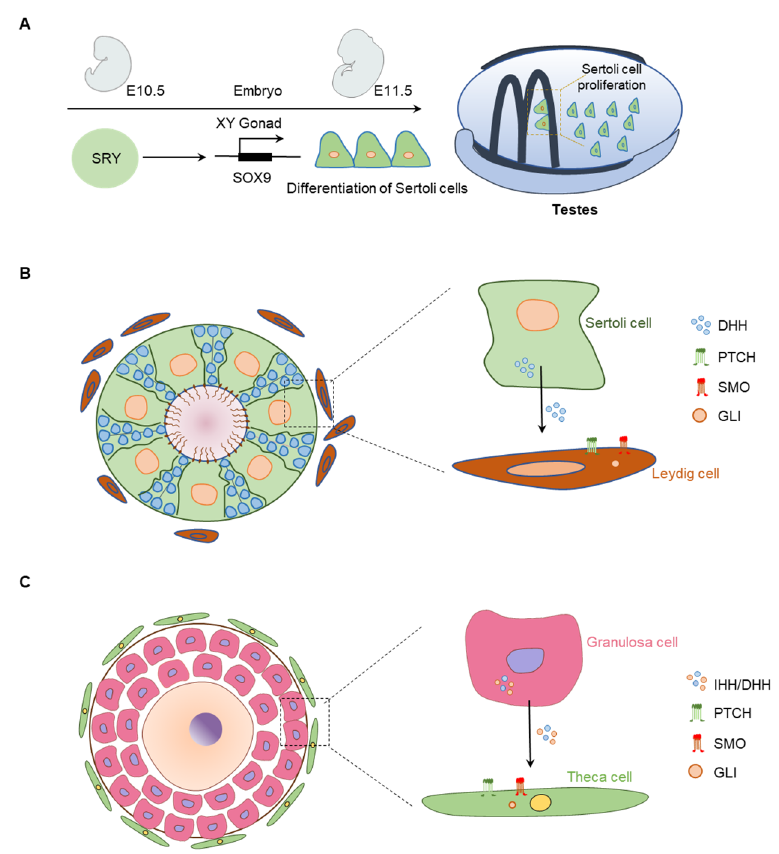
Figure 6. Expression and localization of HH signaling molecules in the gonads. ( A ) Role of the DHH signaling in fetal testis’ morphogenesis and differentiation. Schematic presentation of embryonic